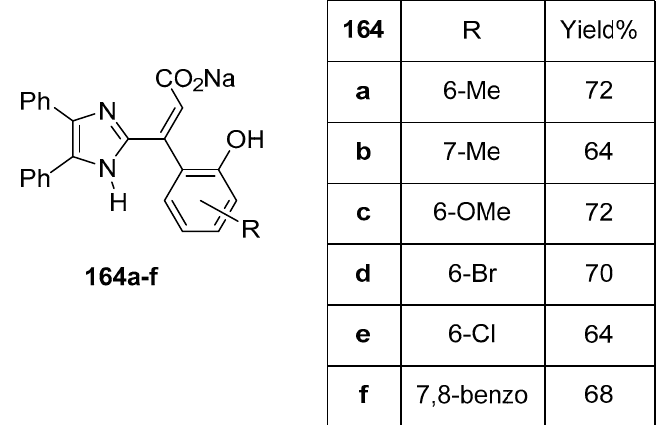
Figure 7. Structure of sodium ( Z )-4-(2-hydroxyphenyl)-4-(4,5-diphenyl-1 H -imidazol-2-yl)but-3-enoates 164a–f.